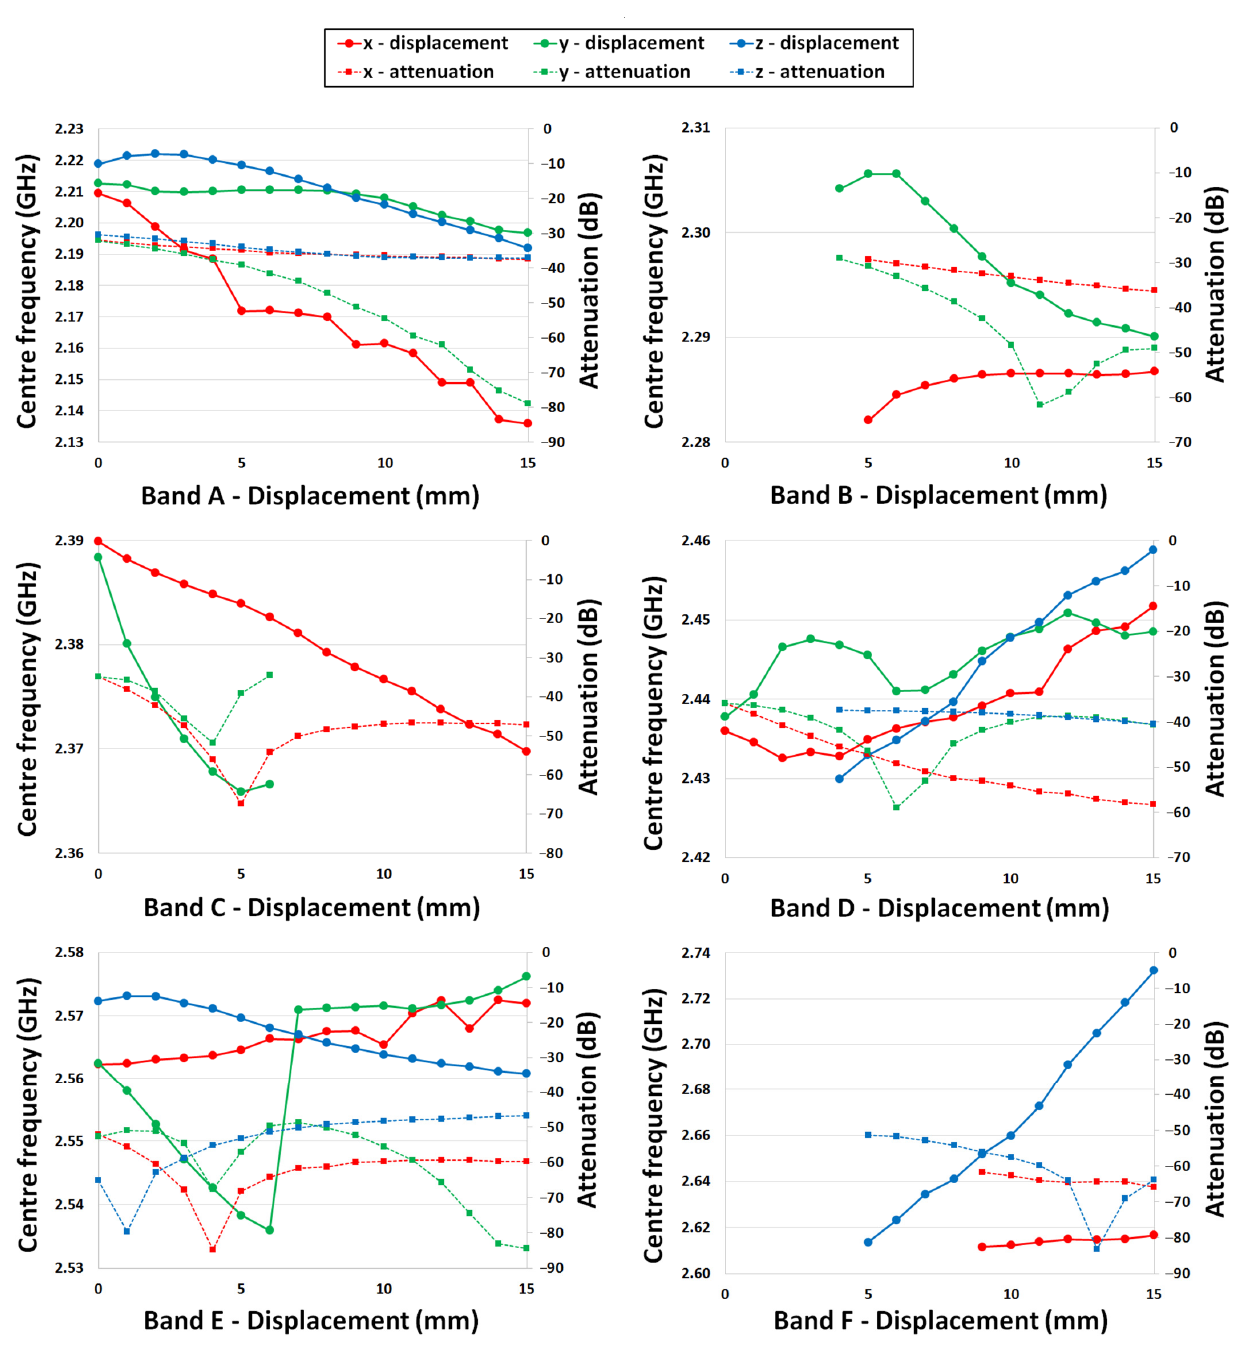
Figure 5. The plots show the frequency (solid line) and attenuation (dotted line) of each feature in bands A to F as x, y and z displacements are introduced between the filters. Considering the above analysis, it was decided that band C is suitable for x displace- ments, band B for y displacements and band F for z displacements, all of which are most effective in the range 6 mm to 15 mm. By resetting the origin to a 10.5 mm offset in the x,y and z directions, this gives the ability of bidirectional-movement sensitivity. Plotting this, as shown in Figure 6, and fitting a second order polynomial (first order in the case of band